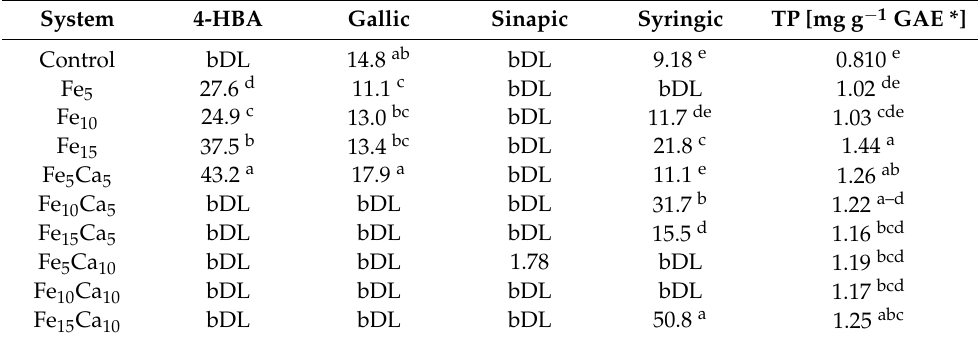
Table 1. Content ( µ g g − 1 DW) of phenolic compounds.